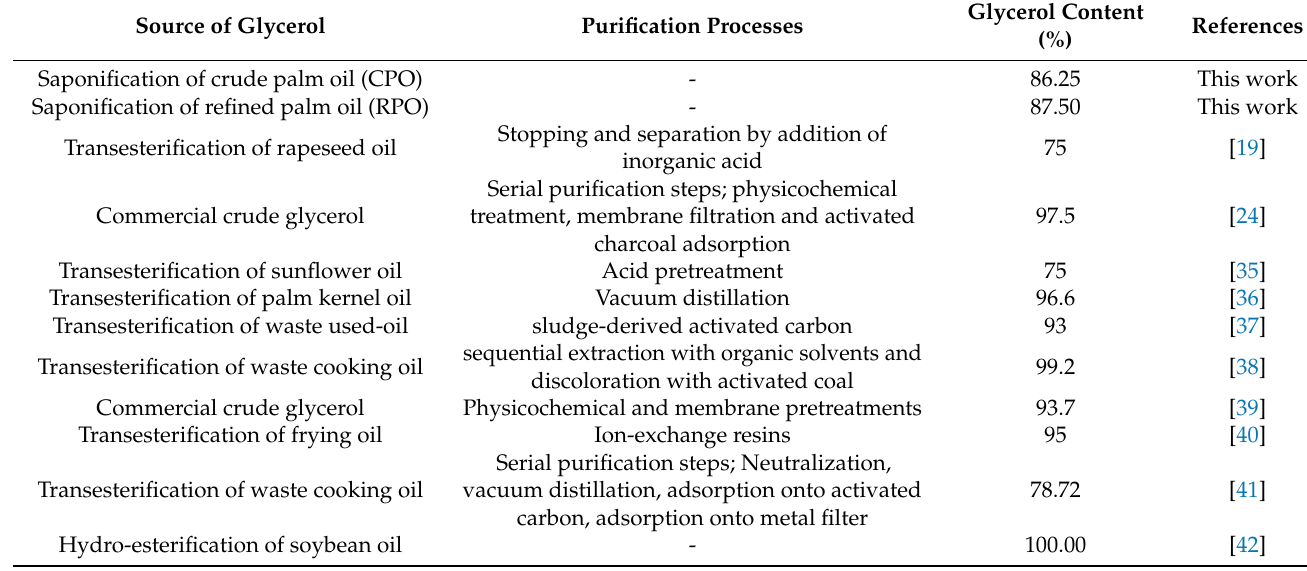
Table 2. Comparative glycerol content obtained from different processing